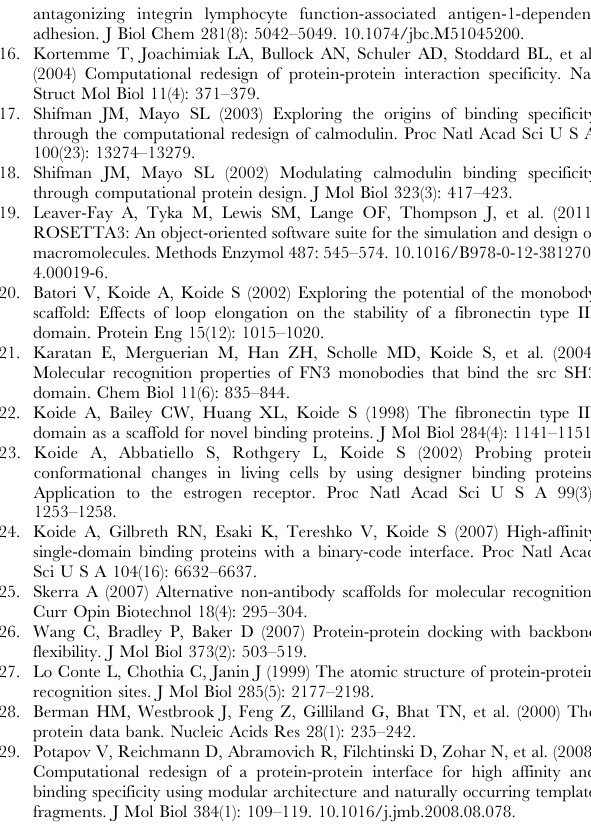
Table S2 Effects of anchor displacement. This table lists the RMSD metrics (see results) for both the standard and anchor- displaced AnchoredDesign benchmarking experiment. The ‘‘stan- dard’’ columns duplicate Table 3 for ease of reading; the ‘‘displaced’’ columns list the values from this new